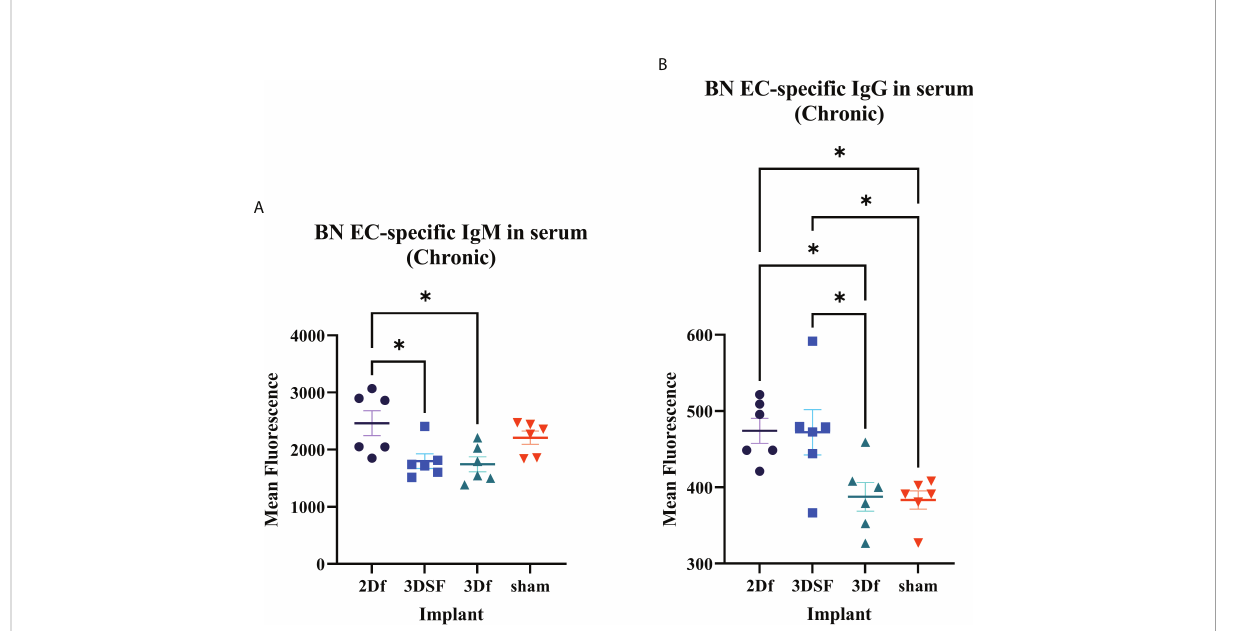
FIGURE 5 Serum antibody levels in rats chronically implanted with allogeneic ECs. Measurement of BN EC-speci fi c antibodies. (A) There was greater circulating IgM in 2Df and 3DSF EC-treated rats. (B) Serum from 2Df and 3DSF EC-treated rats had more IgG than rats implanted with 3Df ECs or no cells. Statistics: Ordinary one-way ANOVA. *(P ≤